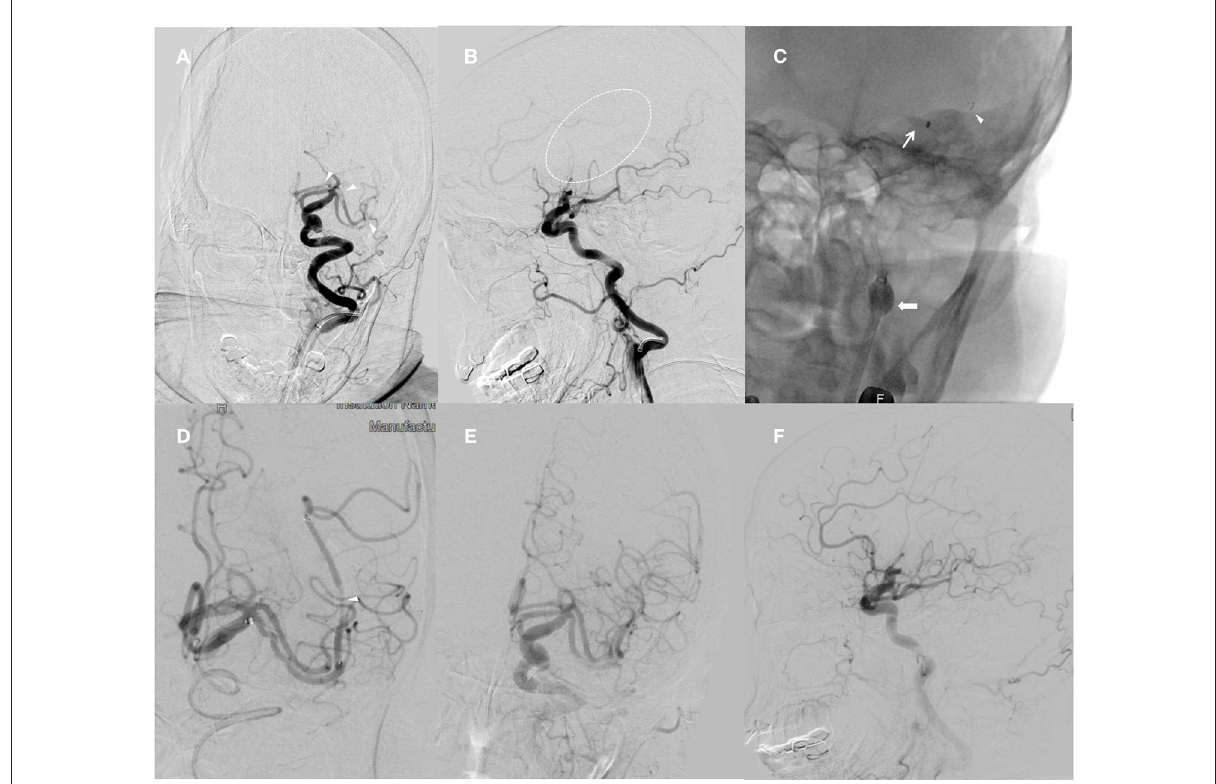
FIGURE2 Angiographic acquisitions, left internal carotid artery injection, and anteroposterior and lateral view obtained during thrombectomy. (A) Demonstration of the left A1 segment of ACA, superior M1 proximal, and inferior Sylvian M2 occlusions (arrow). (B) Lateral view displaying abrupt cutoff of the M1 branch of the left MCA (dashed arrow). (C) Combined balloon guide catheter with stent retriever and distal access catheter technique used in mechanical thrombectomy procedure. The balloon of the BGC is inflated to arrest the antegrade ICA flow (thick arrow). The tip of the DAC indicates placement within the M1 segment (thin arrow). The stent retriever is placed from M1 into the terminal ICA (arrowhead). (D) The same procedure is repeated for the inferior Sylvian M2 occlusion (arrow). (E, F) Full recanalization of the MCA and ACA territory following the second